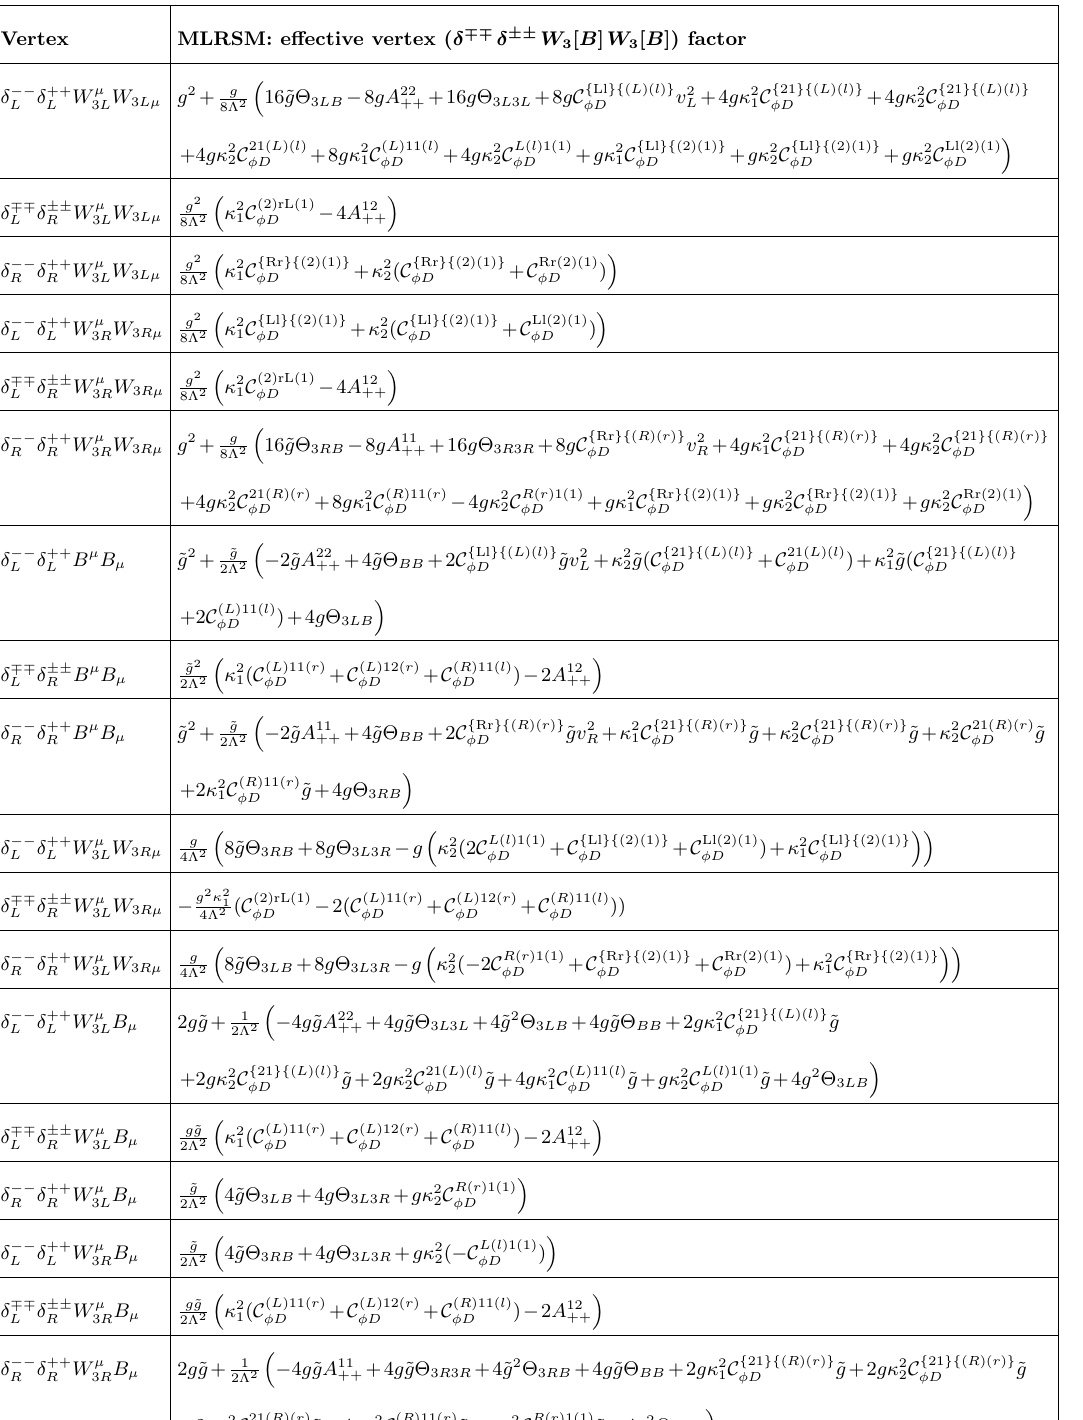
Table 43. MLRSM: coupling of a pair of doubly charged scalars ( (cid:14) (cid:6)(cid:6) ) with a pair two of neutral gauge bosons ( B; W 3 L; 3 R ) in unphysical basis. The vertices can be written in terms of ( A; Z 1 ; 2 ) using rotation matrix ~ . R b